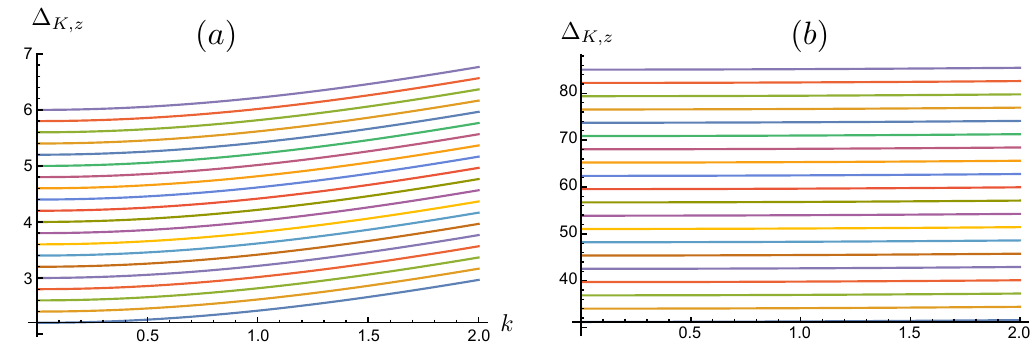
Figure 11: ∆ as a function of k = Ke z at different values of z ranging from z = 22 K , z (bottom) to z = 60 (top) for (a) ζ = 0.1, σ = 0.01, and (b) ζ = − 0.1, σ = 2.01. D = 1 and α = 1 are used for both